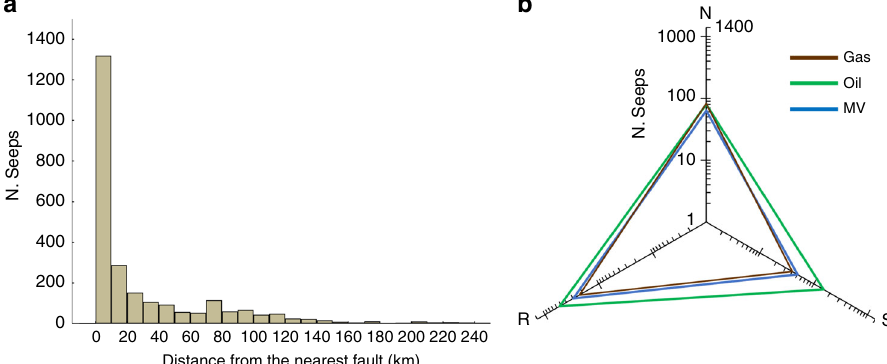
Fig. 3 Seeps versus distance from faults and fault type. a Histogram of the distances between seeps and the nearest fault bearing the faulting style information, as available in the global fault dataset. The distinction by fault type is shown in Supplementary Fig. 10. b Radar diagram showing the number and the type of seeps related to fault type (nearest fault); N: normal, SS: strike-slip, R: reverse; Gas: gas seeps, Oil: oil seeps, MV: mud